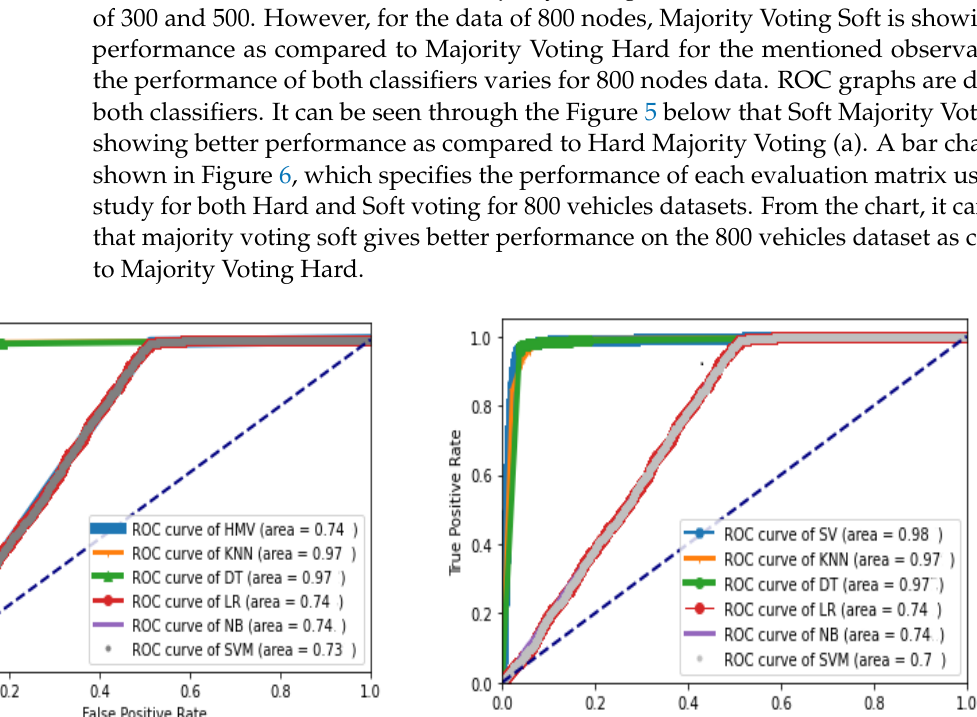
Figure 6. Bar Chart showing performance of Majority Voting Hard and Soft for (800 Nodes data).